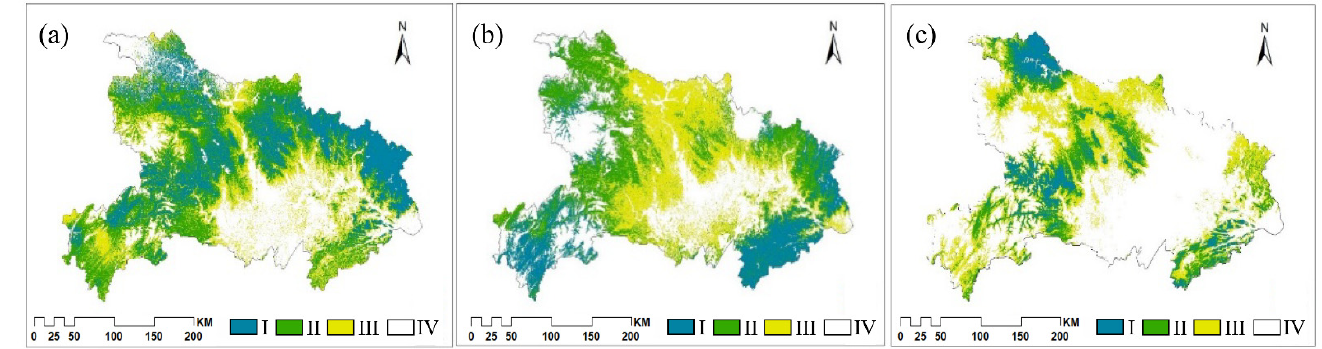
Figure 5. Spatial distribution map of suitability of ( a ) Masson pine, ( b ) Chinese fir and ( c ) Chinese thuja. I, II, III and IV represent strong suitable, medium suitable, weak suitable and not suitable for species.